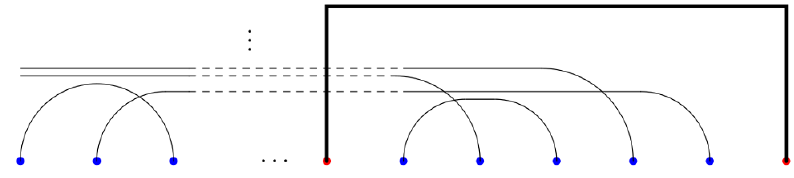
Figure 6 . Marked chord diagram for a two point